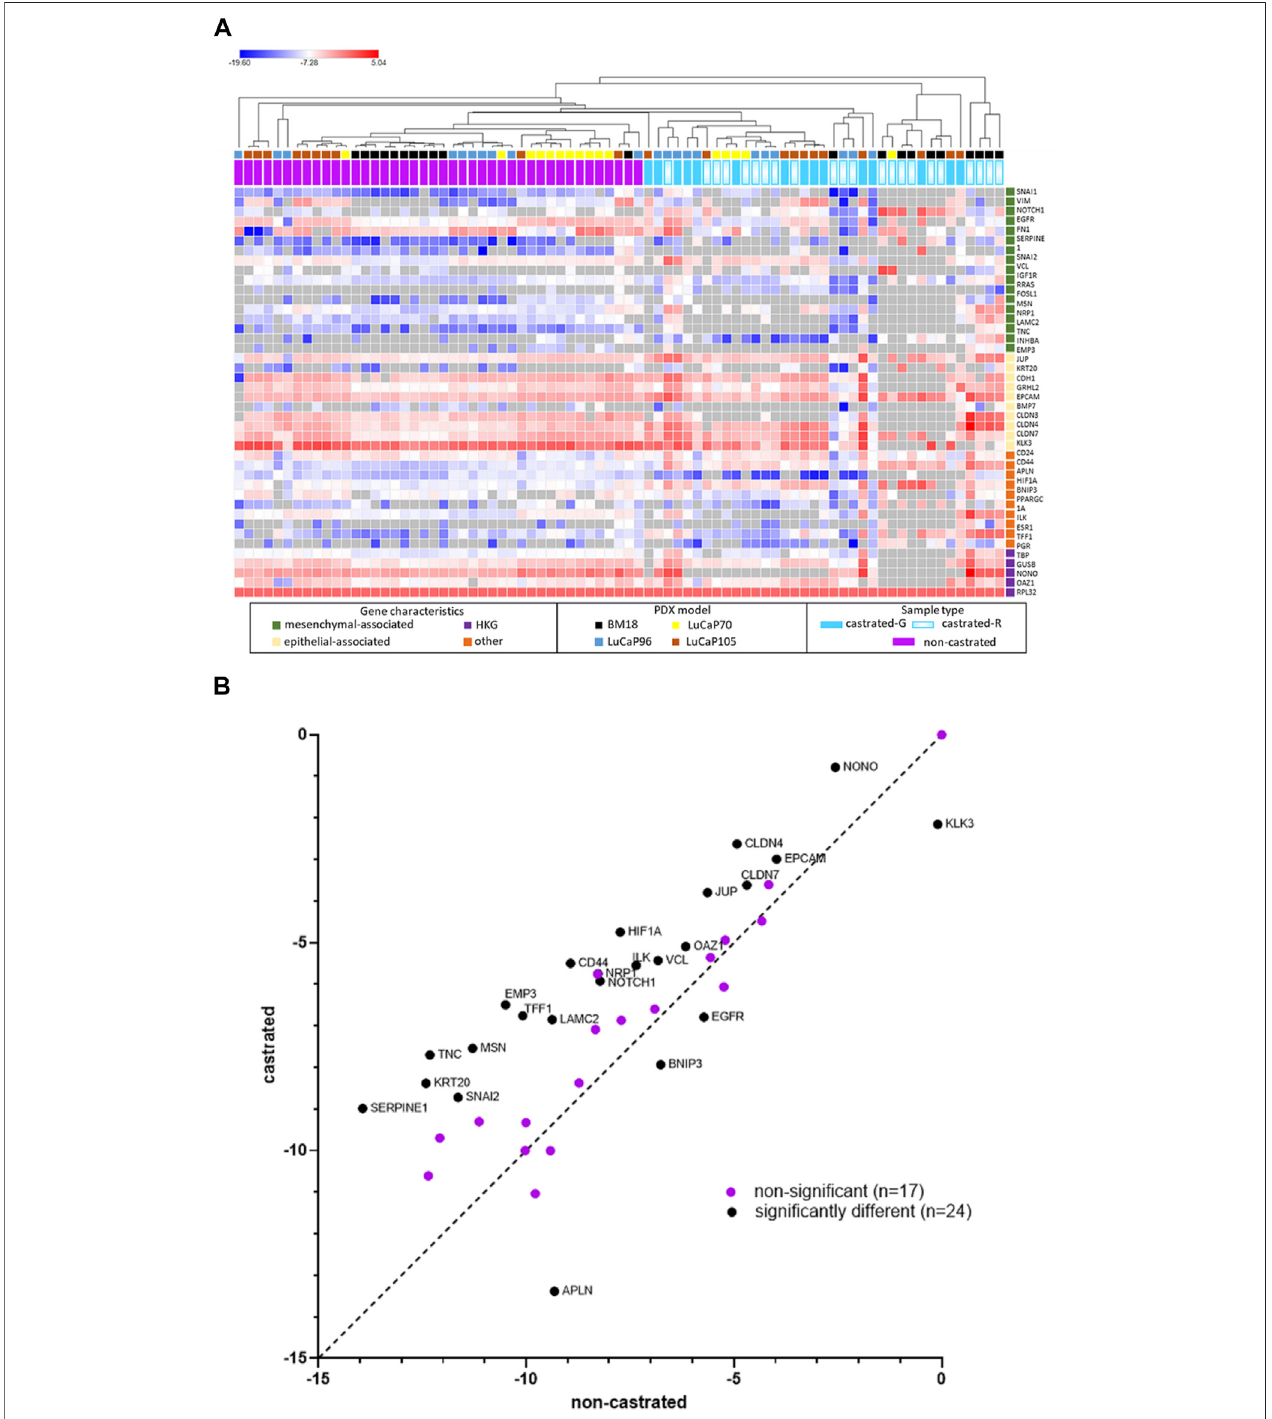
FIGURE8| RPL32normalised Δ Ctvaluesfor42genesusingRT-qPCRanalysisoftumoursamplesfromcastratedandnon-castratedPDX-bearingmice.Thedata for the non-castrated mice has been published previously (Hassan et al., 2021b). (A) Heat map represents individual samples, where each row corresponds to a gene and each column corresponds to a tumour sample. Unsupervised hierarchical clustering was performed using one minus Pearson correlation and global normalisation. Bright red denotes high expression and bright blue denotes low expression of individual genes. Grey represents no detection. Tumour status in castrated mice is indicated (regressed (castrated-R) or growing (castrated-G)). (B) Scatter plots of overall tumour gene expression results for non-castrated PDX mice versus castrated mice. Each point denotes an individual gene. Unpaired, two-tailed t -tests showed 24 genes had signi fi cant difference for gene expression ( p < 0.05).